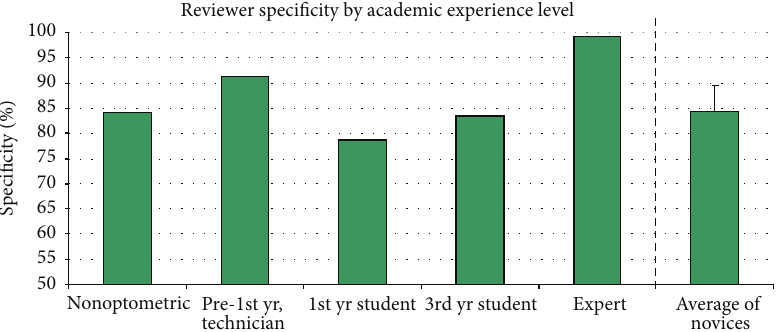
Figure 2: Specificity of reviewers for identification of healthy eyes among those with posterior segment disease, based on data provided with iWellnessExam™. Rightmost column is an average of the performance of the four